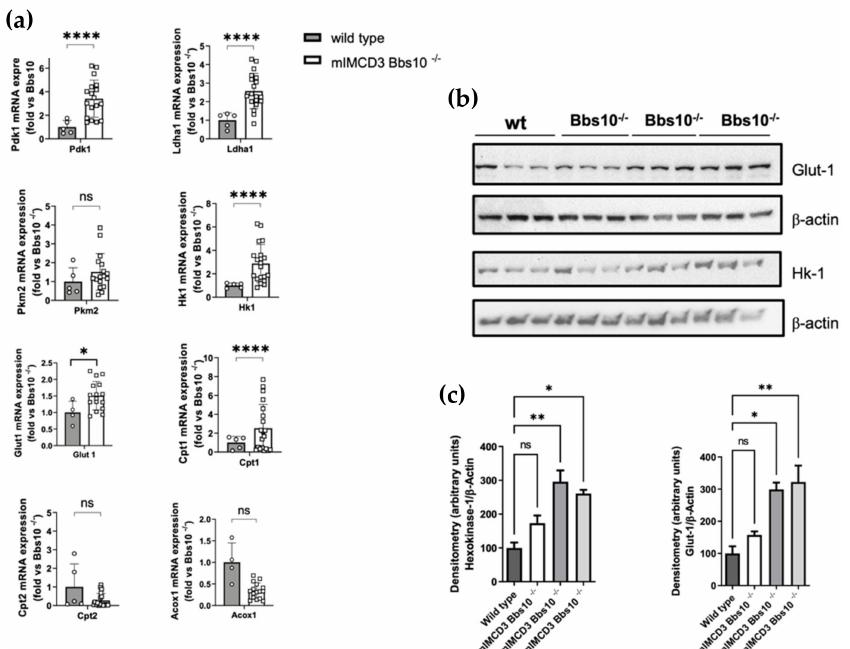
Figure 4. Bbs10 depletion affects energy metabolism in kidney-derived epithelial cells . ( a ) Relative mRNA expressions levels of key metabolic enzymes including Pdk1, Ldh1, Pkm2, Hk-1, Cpt-1, Cpt2, Acox-1, and Glut-1 (H) in IMCD3- Bbs10 -/- cells ( n = 20) and wild type cells ( n = 5). Data are presented as mean ± SEM and are normalized to wild type controls as the y -axis is indicated by the fold. The statistical significance of the difference in mRNA expressions between conditions (IMCD3- Bbs 10 -/- cells and wild type controls) was evaluated by an unpaired parametric t-test with Welch correction (* p < 0.05, ** p < 0.01, **** p < 0.0001, ns = not significant). ( b ) Western blot analysis of the expression of hexokinase and Glut-1 in IMCD3- Bbs10 -/- cells and wild type. β -actin was used as the loading control. ( c ) Quantitative densitometric analysis was performed for data analysis and showed an increase in Glu-1 and Hk-1 also at protein levels ( p -value < 0.05). Data are shown as the means ± SEM and are representative of three independent experiments, each performed in triplicate.